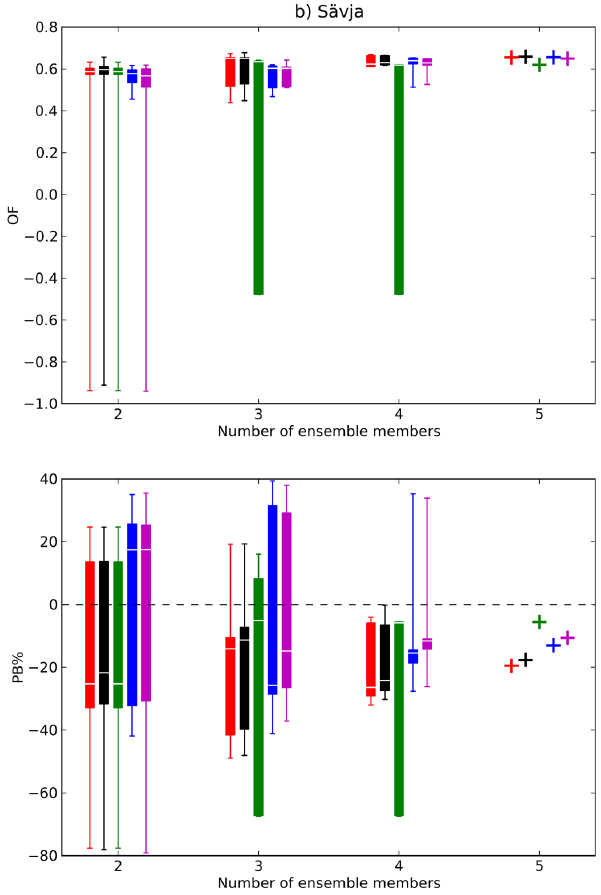
Fig. 4b. Criteria values distribution depending on applied scheme (red: ME; black: WM; green: MD; blue: UR; magenta: CR; see Table 2 for abbreviations) and number of ensemble members at S¨avja. Missing crosses indicate unrealistic negative prediction ob- tained with UR or CR schemes. OF=objective function according to Eqs. (1) and (2); PB%=percent bias according to Eq.